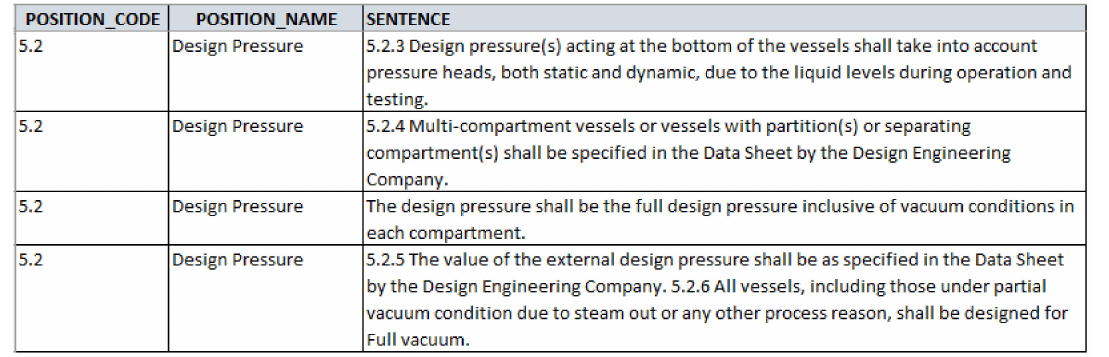
Figure 6. PDF normalization module result